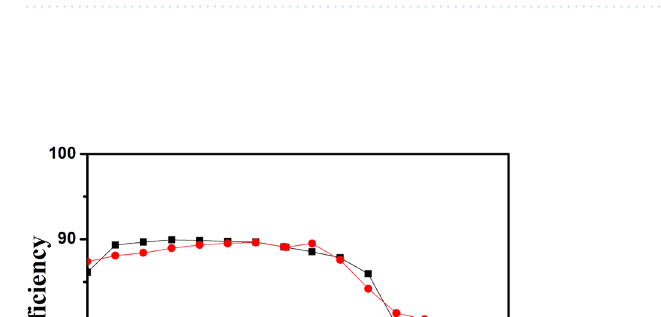
Figure 17. Projected MIMO (M-shaped) antenna polar plot ( a ) E-plane, ( b ) H-plane at 3.65 GHz.